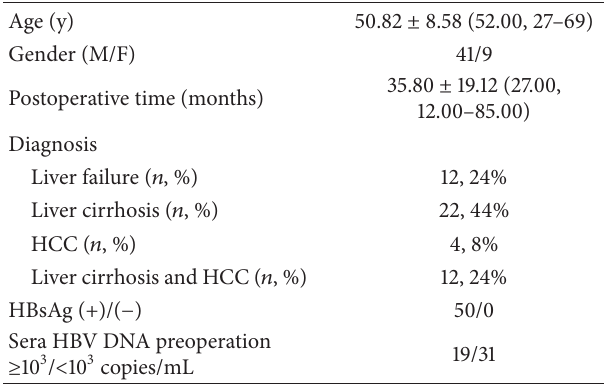
Table 1: Demographic, etiological, and virological features of the 50 cases with a successful response before OLT.